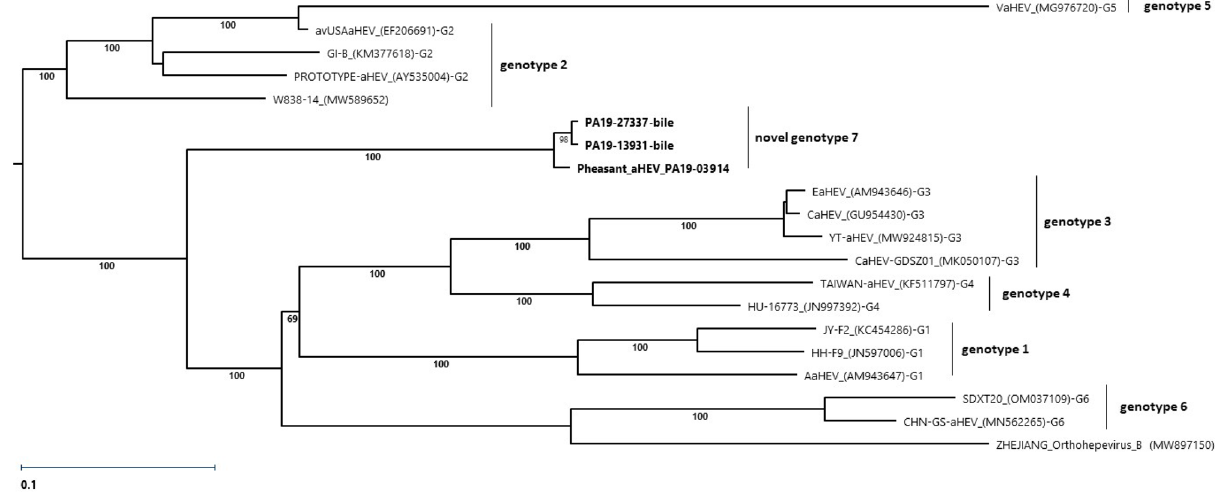
Figure 4. Phylogenetic analysis of Orthohepevirus B genomes. The analysis was performed using the Maximum Likelihood method (RAxML) and was based on the alignments of conserved sites that included 6405 positions in the final dataset. The unrooted tree with the highest log likelihood (− 43,903.392991) is shown. This analysis involved 20 nucleic acid sequences. All genomes from the Genbank are labelled with the name, accession number in parenthesis, and the designation of the corresponding genotype as G-number. Sequences obtained in the present study are labelled in bold. The robustness of the tree was tested by the bootstrap analysis with 500 iterations and the percentage of trees in which associated taxa clustered together is shown next to the branches. Evolutionary analysis was conducted in the MegAlign Pro module of Lasergene v17.3 software (DNASTAR, Madison, WI,